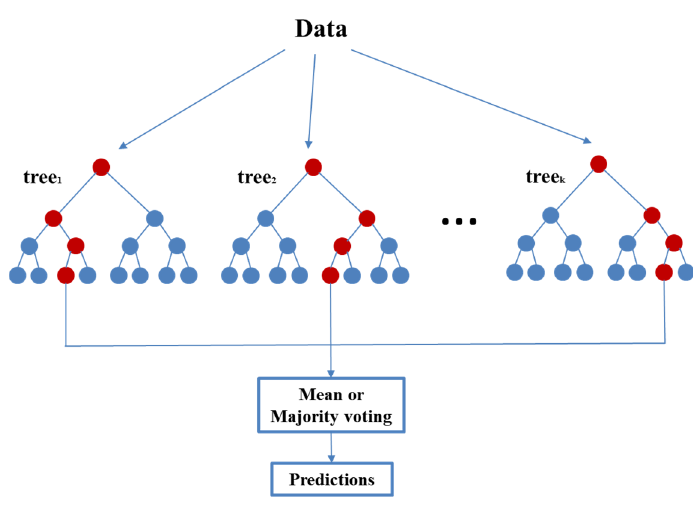
Figure 4. Basic principle of RF.